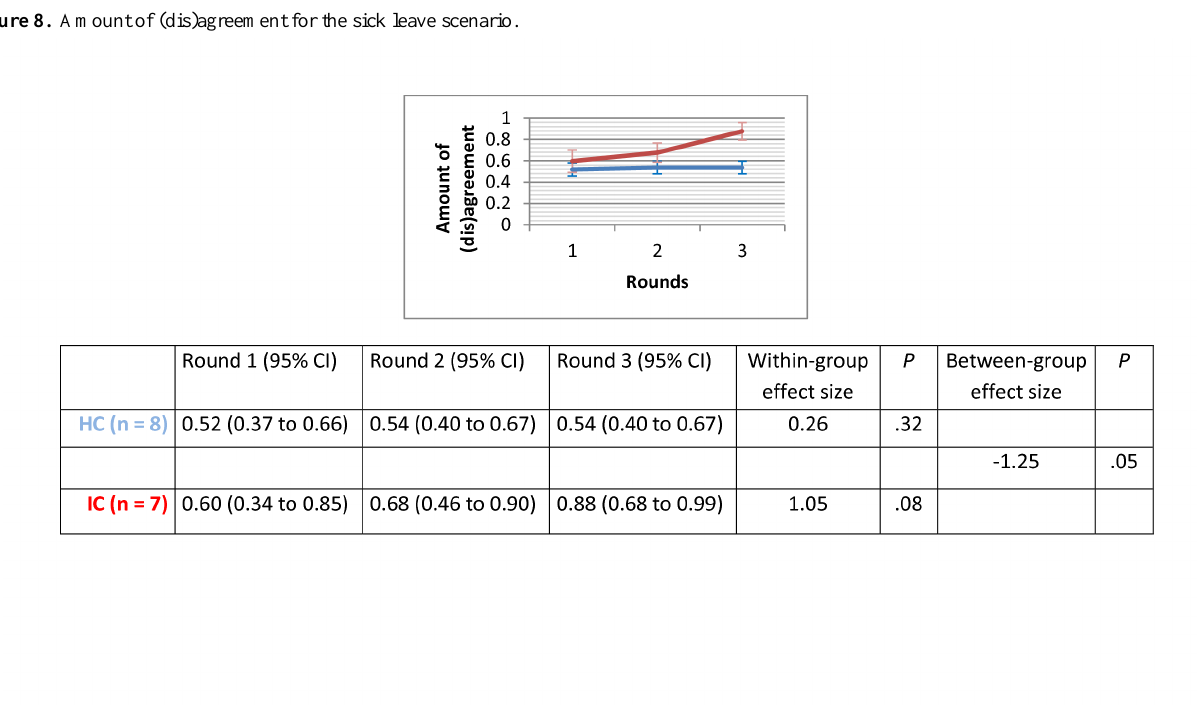
Figure 8. Amount of (dis)agreement for the sick leave